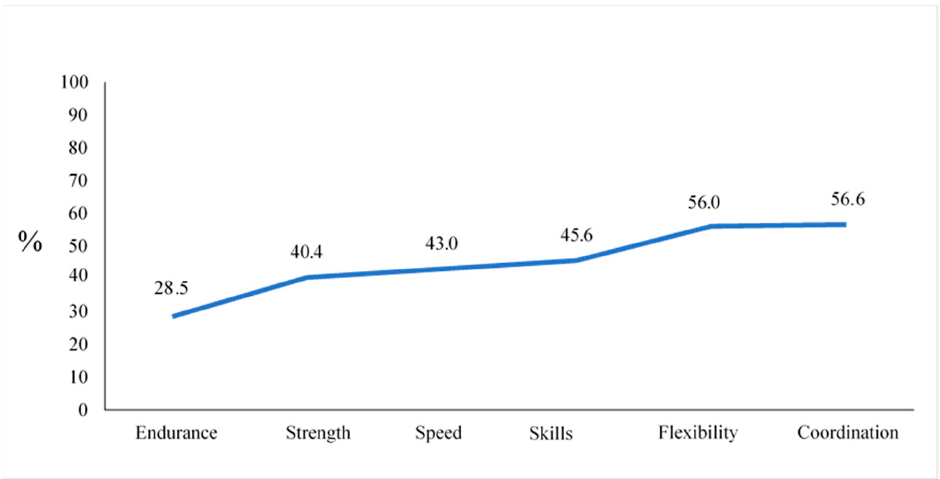
Figure 3. Frequency of a positive self-concept in the CHD group (in percent). Table 5. Frequency of a positive self-concept per CHD group and reference.